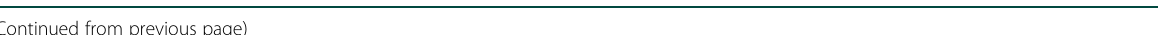
algorithm: the cytoplasmic rods and rings pattern, the nu- clear quasi-homogeneous pattern and the nuclear